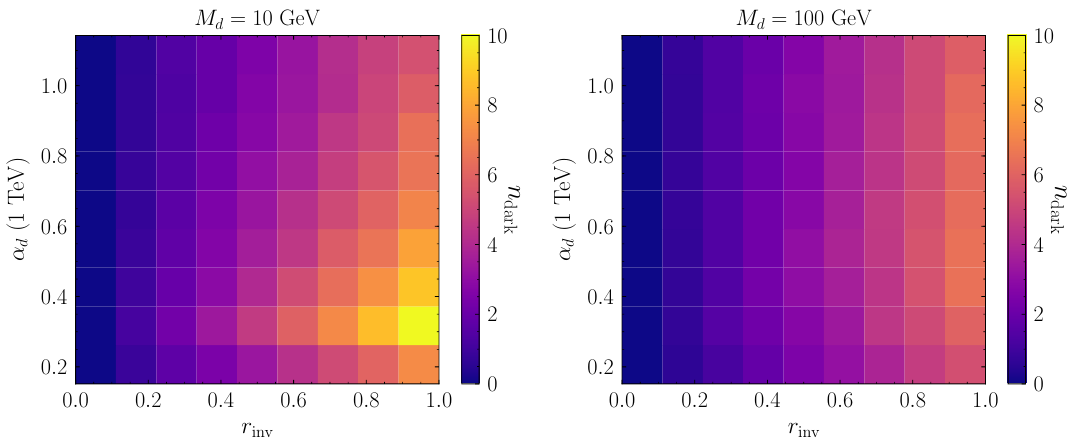
Figure 2 . The number of dark hadrons that are produced per event for di(cid:11)erent values of (cid:11) and r inv . The left panel corresponds to the dark hadron mass scale M d = 10 GeV, while the right panel corresponds to M d = 100 GeV. Here, (cid:11) d = 2 (cid:25)= ( b log( 1 TeV 2 scale and b = 11 N c N f . Note that (cid:11) d (1 TeV) = 0 : 23 (0 : 45) approximately corresponds to 3 3 (cid:0) (cid:3) d = 10 (100) GeV. The simulation used to generate this (cid:12)gure is described in section